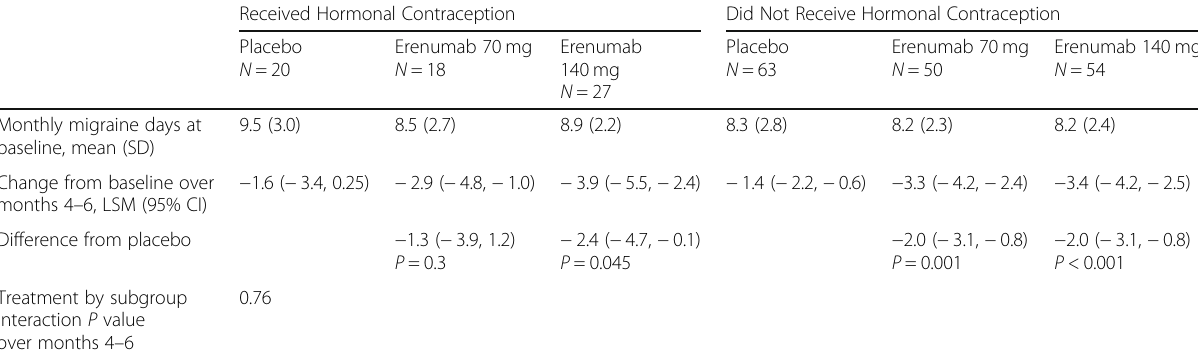
Table 3 Change From Baseline in Mean Monthly Migraine Days by Hormonal Contraception